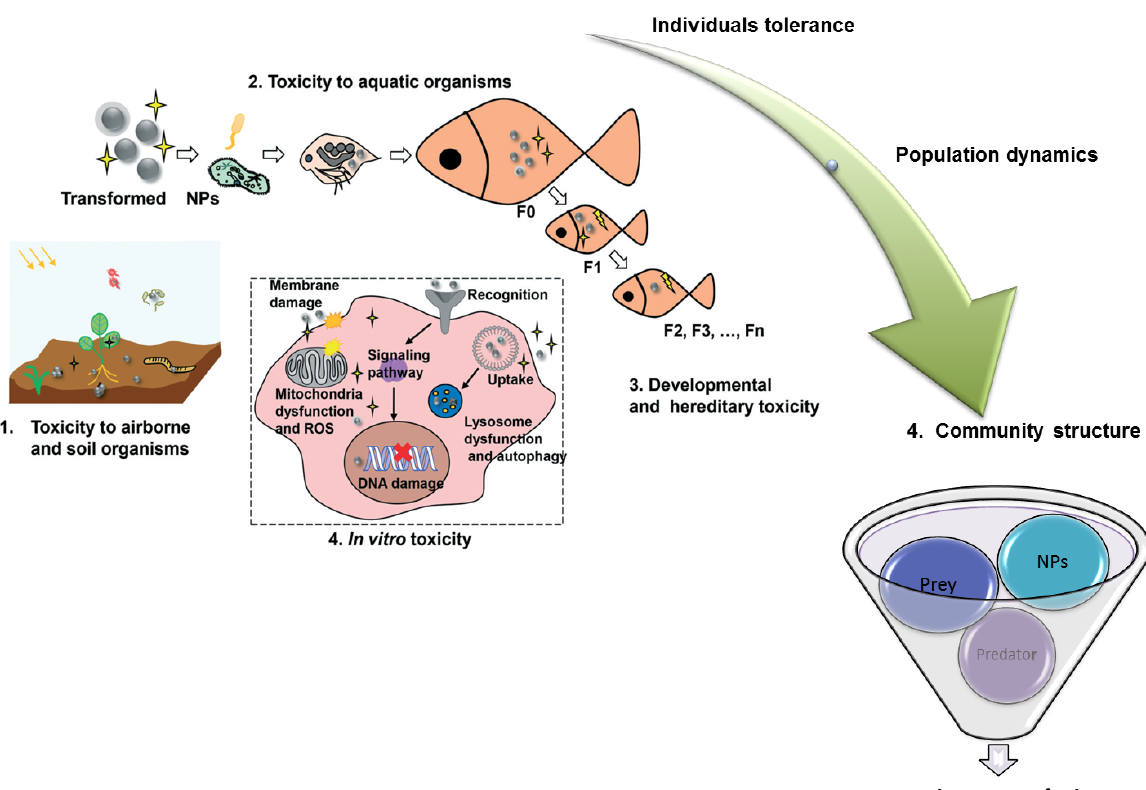
Figure 1. The adverse effects of NPs on aquatic community structure and bioaccumulation are summarized. Adapted from